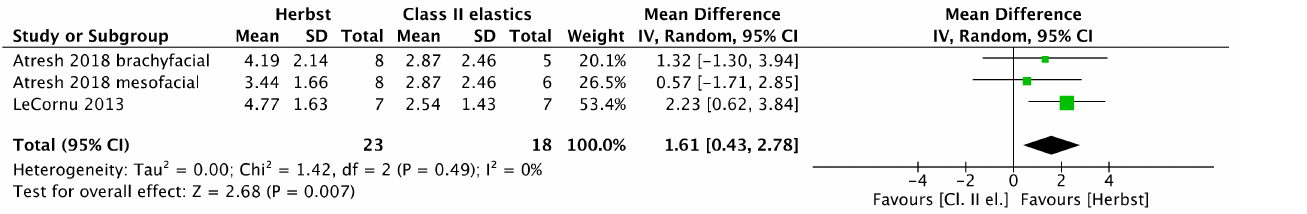
Figure 19. Forest plot of the right mandibular ramus height changes using the random effects model [43,44].